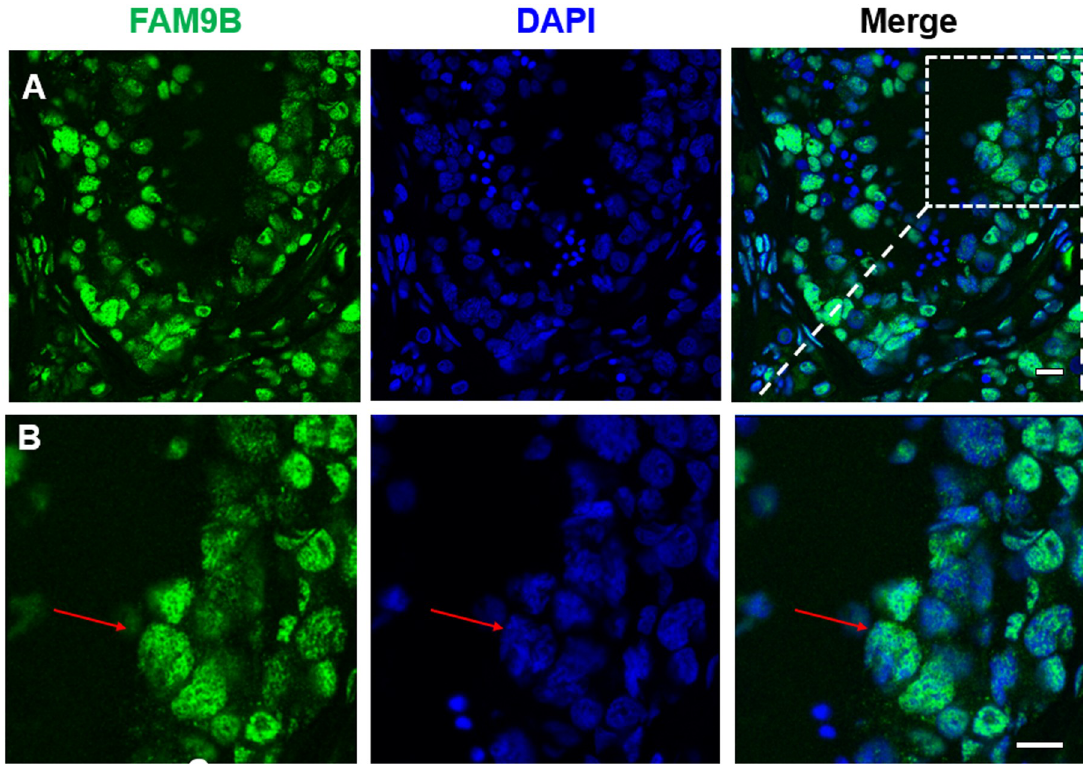
Fig 3. Immunostaining results for FAM9B expression in human testicular sections. (A) FAM9B (green) is clearly present in both testicular cell nucleus and cytoplasm, localized in primary spermatocyte nucleus (red arrow), and evident in sertoli cell cytoplasm. FAM9B (green) is localized in the nucleus of germ cells shown by red arrows. Nuclei are stained with DAPI (blue). Bars = 10 μ m.